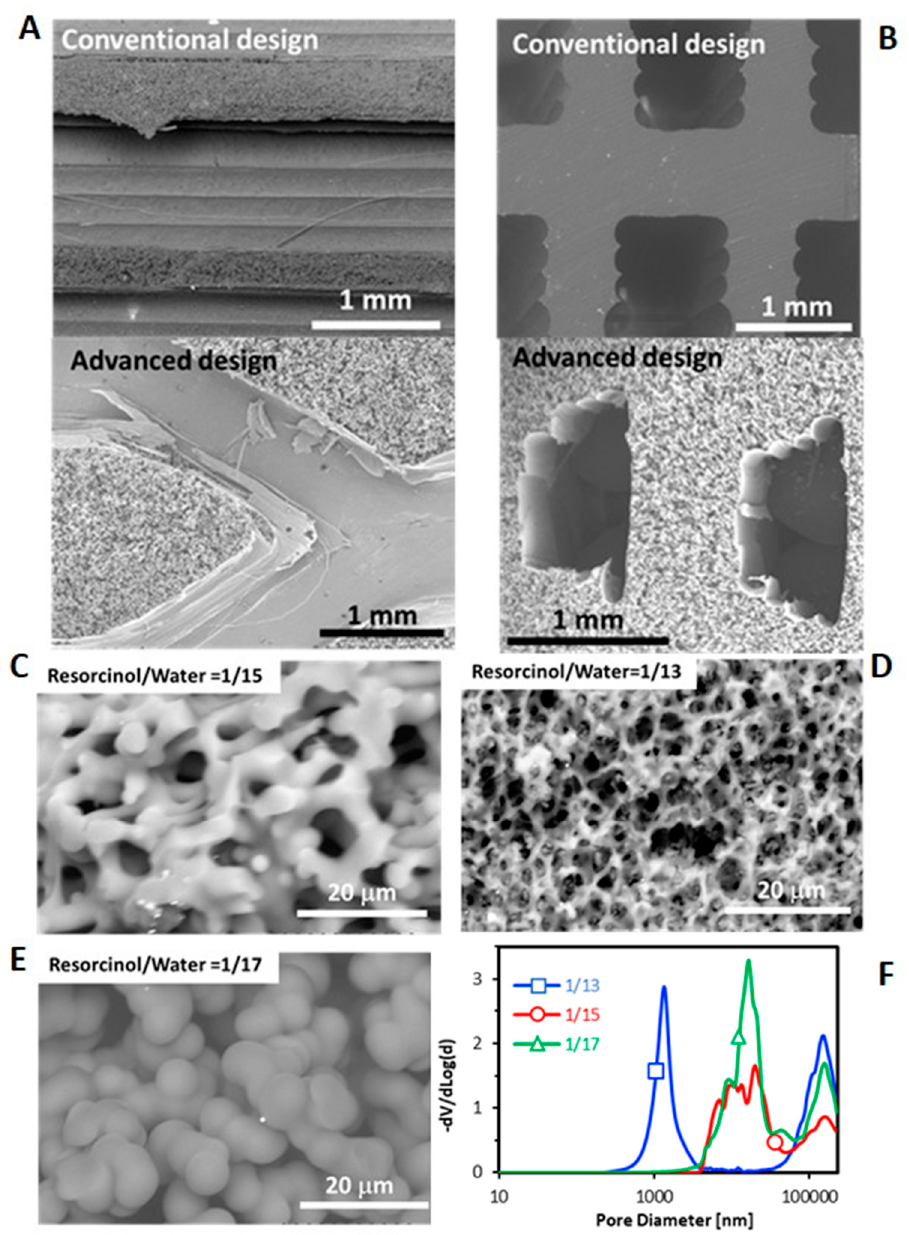
Figure 3. SEM images of 3D-printed monoliths with both channel configurations prepared with R/W molar ratio of 1/17 ( A , B ) and different R/W ratio for conventional design ( C – E ) and Hg-porosimetry plot ( F ). ( A ) longitudinal section and ( B ) Cross section.